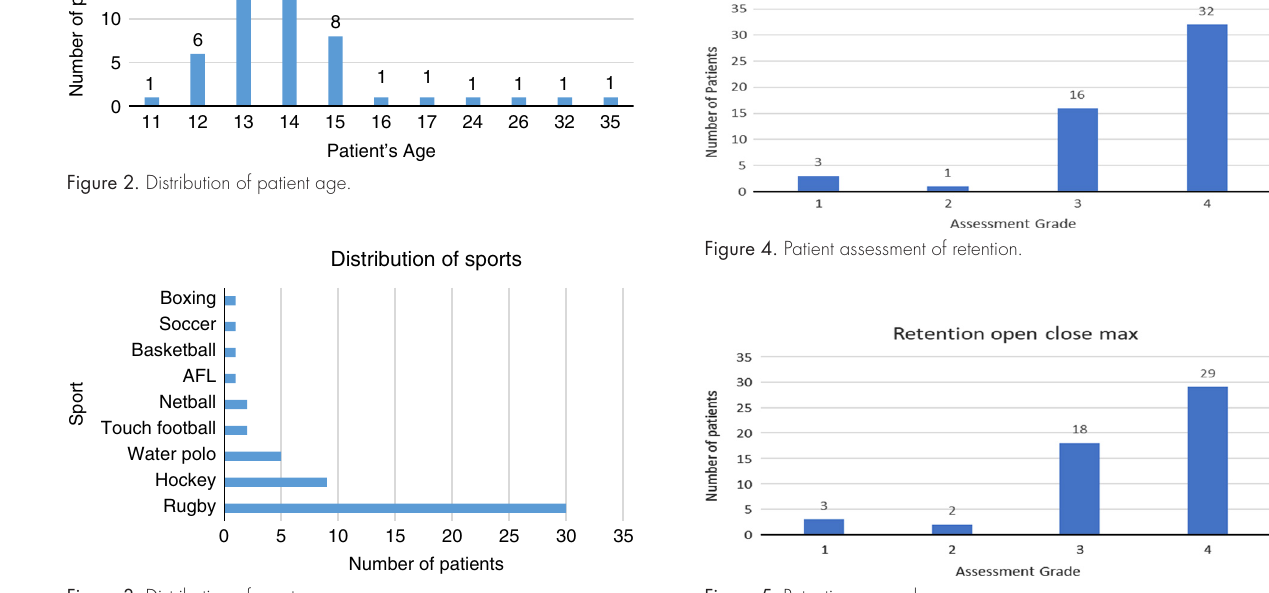
Figure 5. Retention open close